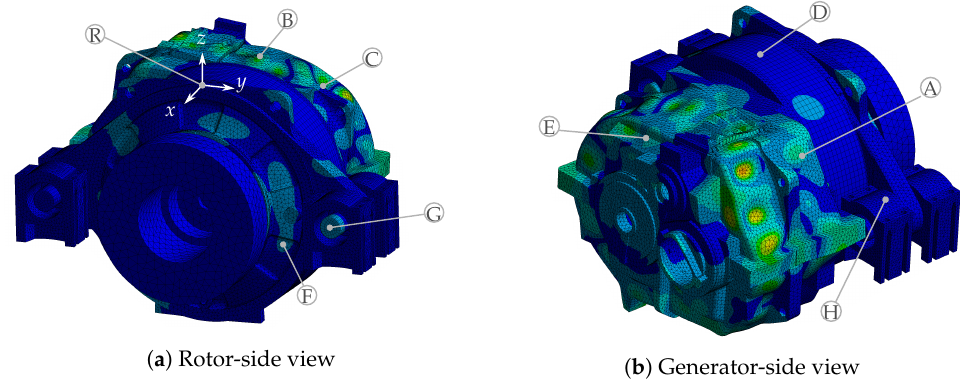
Figure 18. Operational shape to TE excitation at HS stage with ω = 6300rads − 1 and selected sensor positions A-H (order in increasing distance to vibration sources).